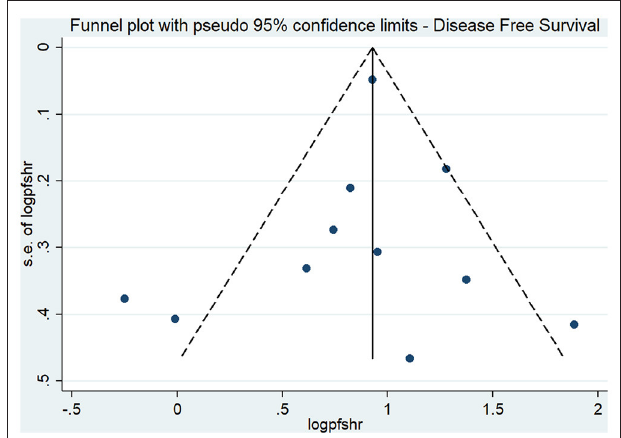
FIGURE 6 | Funnel plot for disease-free survival.